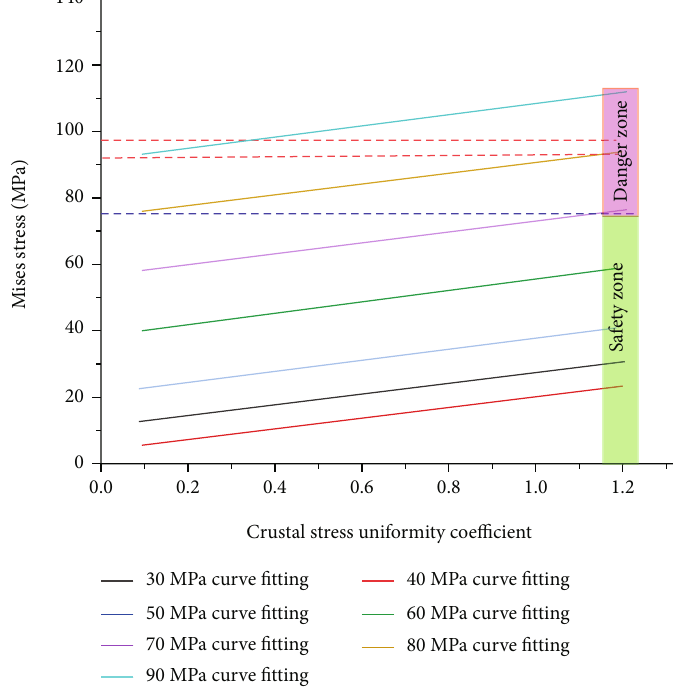
Figure 12: Curve of the borehole wall max-Mises stress and stress uniformity coe ffi